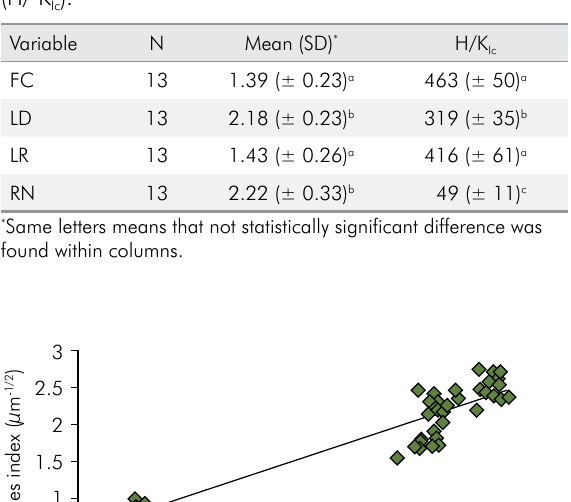
(MPa m 1/2 ) Ic Ic